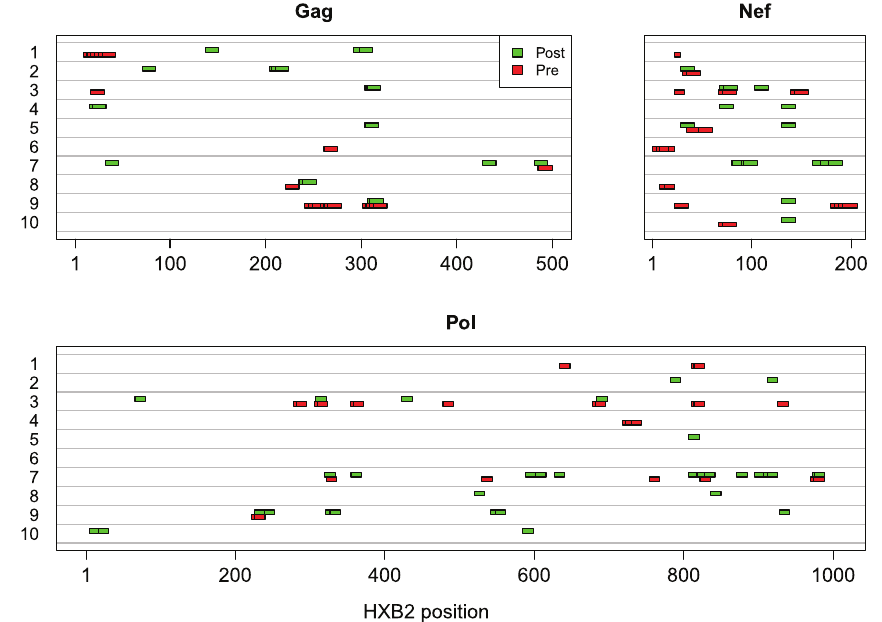
Figure 3. Comparison of Pre- and Post-Infection T-Cell Responses. Pre- and post-infection T-cell responses to individual 15-mers in Gag, Pol, and Nef as measured by IFN c ELISpot. Each row represents a different subject. Pre-infection responses were measured using vaccine-matched peptides and post-infection responses were measured using PTE-G peptides.